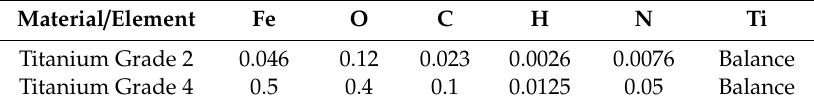
Table 1. Element composition of the experimental materials (weight